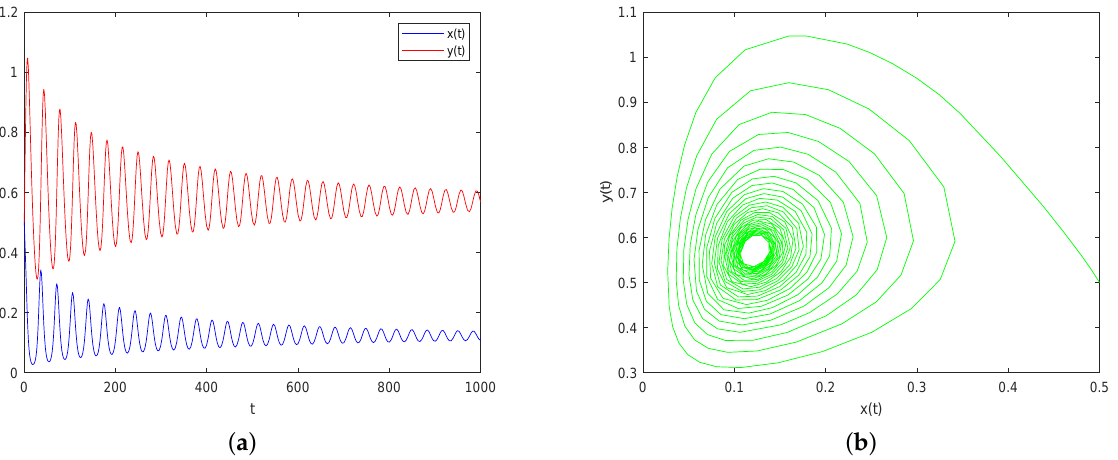
Figure 9. ( a ) Time series and ( b ) phase portrait of E ∗ for system (1) when τ 1 = 3.5 and τ 2 = 0.5. Other parameters are the same as in (32).